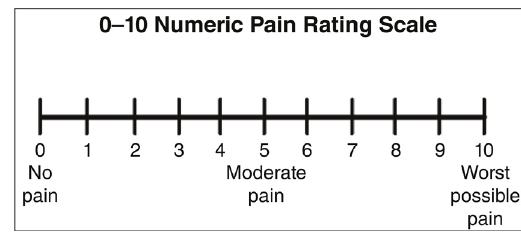
Figure 2. Numeric pain rating on a scale of